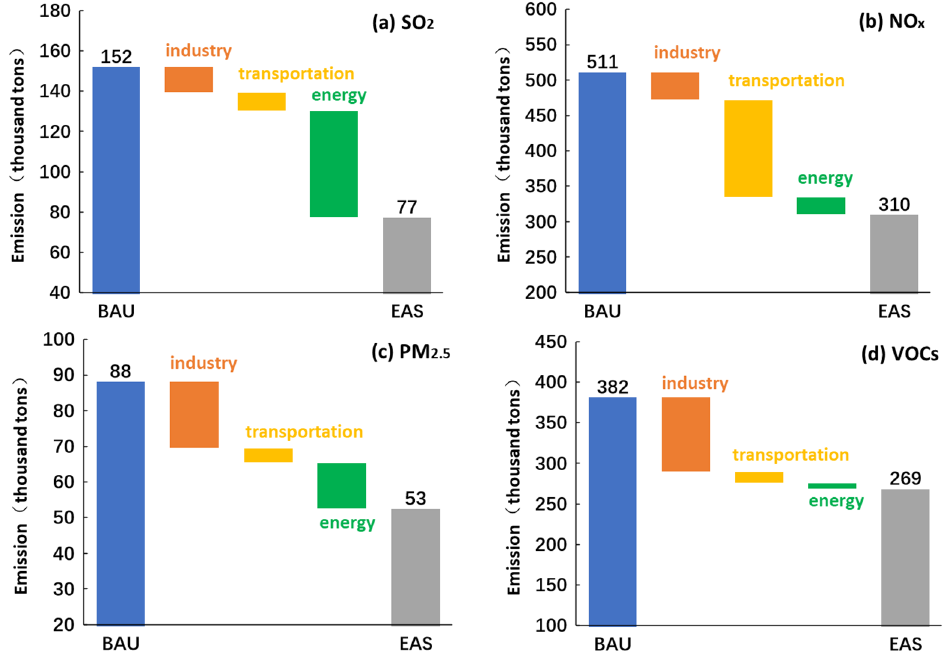
Figure 6. Contributions of different sector to pollutants’ emission reduction compared between BAU and EAS scenarios: ( a ) SO 2 , ( b ) NOx, ( c ) PM 2.5 , ( d ) VOCs. and EAS